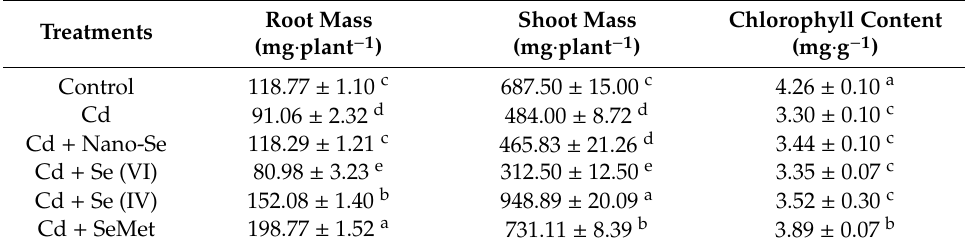
Table 1. E ff ects of Se forms on the mass of roots or shoots and chlorophyll content in the presence of Cd. Data are expressed as mean values ± SD ( n = 3). The di ff erent letters indicate statistically significant di ff erences between the treatments at p <